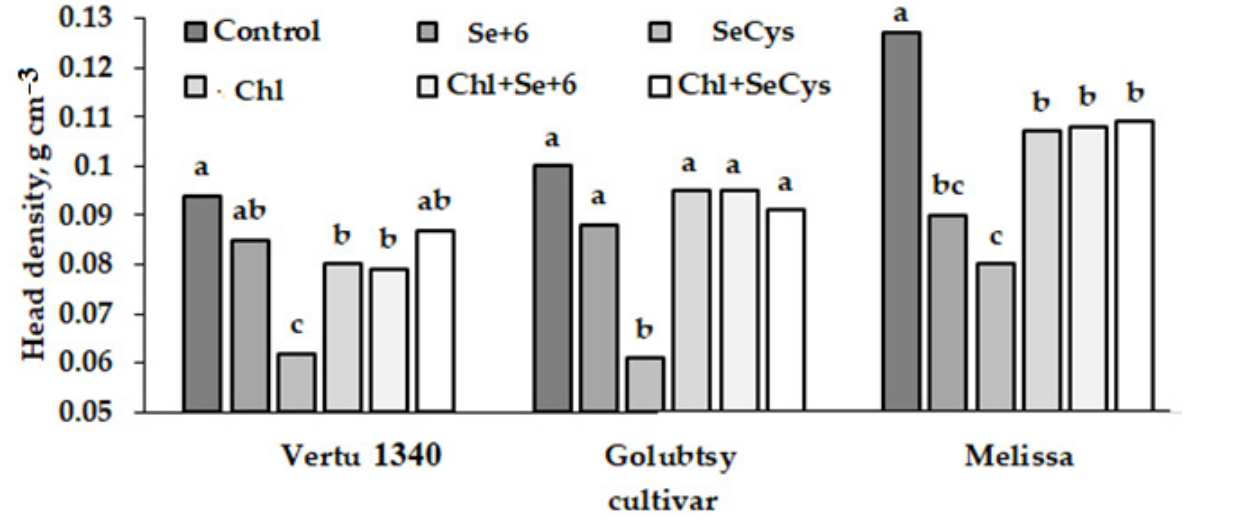
Figure 1. Head density of Savoy cabbage as affected by selenium biofortification and Chlorella application. Values with the same letters do not differ statistically according to the Duncan test at p < 0.05.